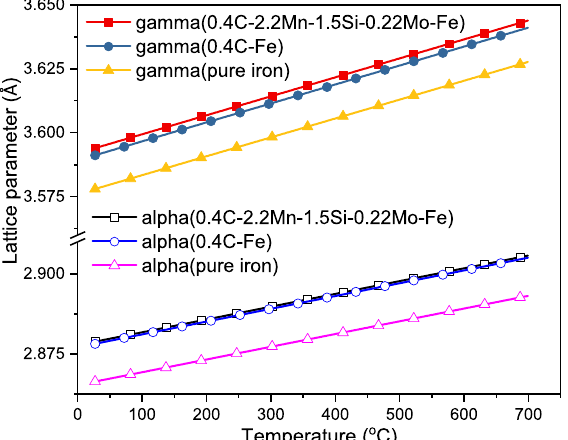
Figure 6. Lattice parameters of gamma and alpha phase as a function of temperature in pure iron, C-Mn, and bainitic steels.